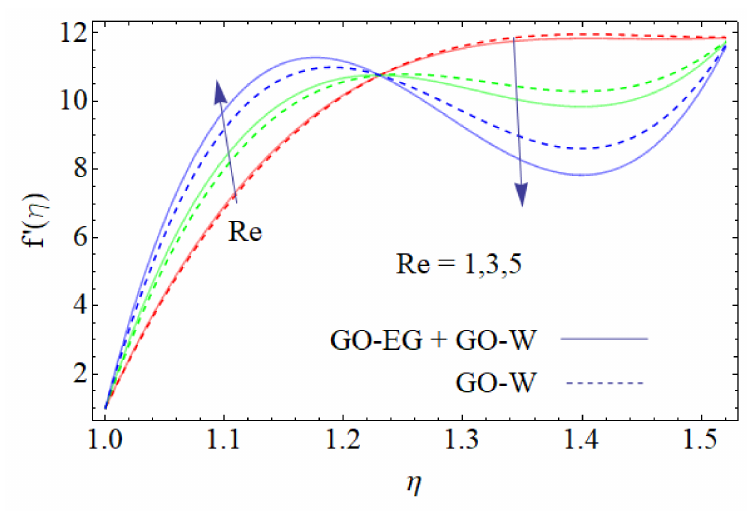
Figure 4. Influence of the Reynolds number on the velocity profile.